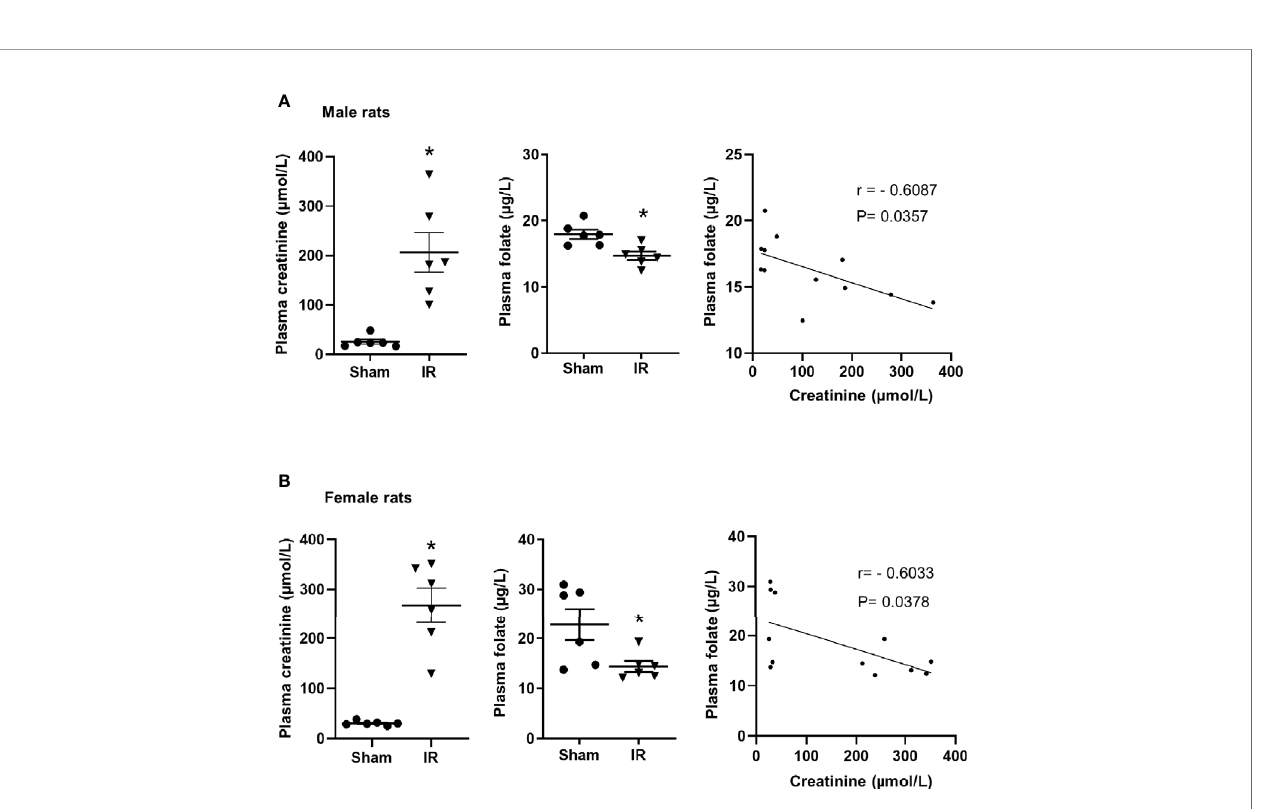
FIGURE 1 | Plasma creatinine and folate measurement in rats. Rats were subjected to kidney ischemia-reperfusion (IR) or sham operation (sham). Plasma creatinine and folate were measured in (A) male and (B) female rats. Pearson ’ s correlation between plasma folate levels and plasma creatinine levels was analyzed. Results are expressed as mean ± SE (n = 6). * P < 0.05 when compared with the value obtained from the sham-operated